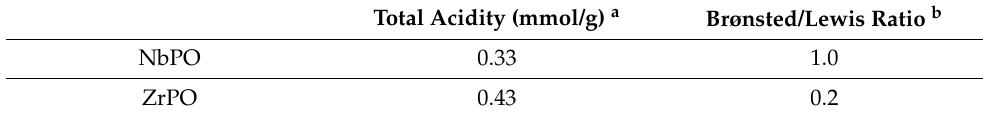
Table 2. Acid properties of NbPO and ZrPO under hydrous conditions